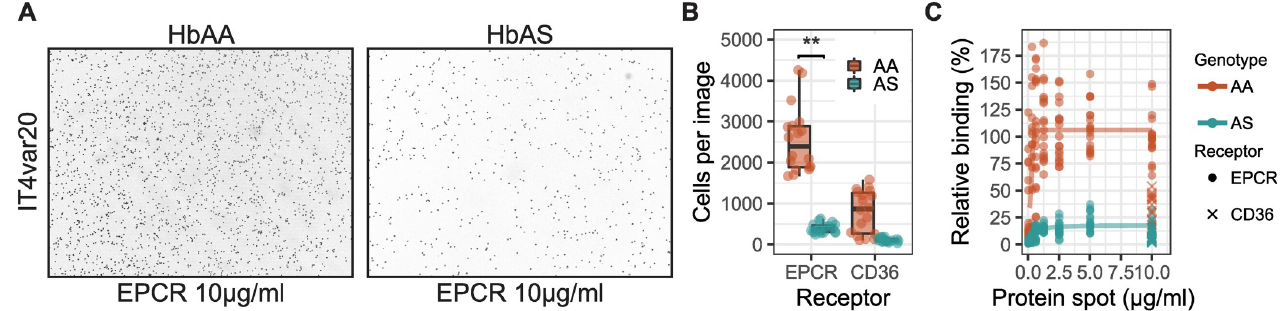
Fig 3. Sickle-trait hemoglobin effects on erythrocyte adhesion to EPCR. A) Erythrocytes infected with IT4 parasite-strain expressing IT4var20 adhering to spots of recombinant EPCR on a petri-dish. B) Quantification of IT4var20-infected normal (HbAA) erythrocytes and sickle-cell trait (HbAS) erythrocytes adhesion to 10 μ g/ml EPCR and CD36 spots. Each condition was done as 2 protein spots on separate petri-dishes, each imaged 3 times. The assay was done 3 independent times (n = 3). Wilcoxon’s signed rank test was used to evaluate statistical significance ( �� p-value = 0.0002). C) Relative adhesion across protein spots at different concentrations normalized to the mean adhesion to EPCR at 10 μ g/ml. Four parameter logistic curve was fitted to the normalized data for HbAA and HbAS.